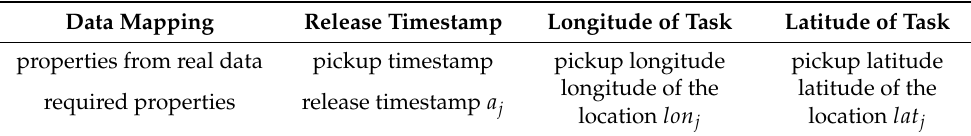
Table 1. Mapping table of partial attributes required by spatial task. Data Mapping